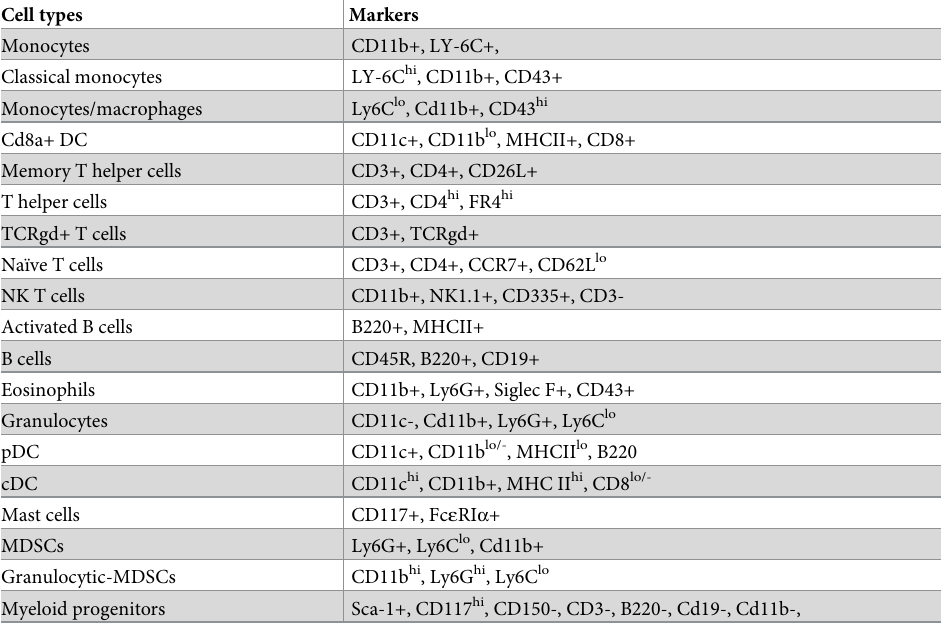
Table 1. Mouse CyTOF immunophenotyping.